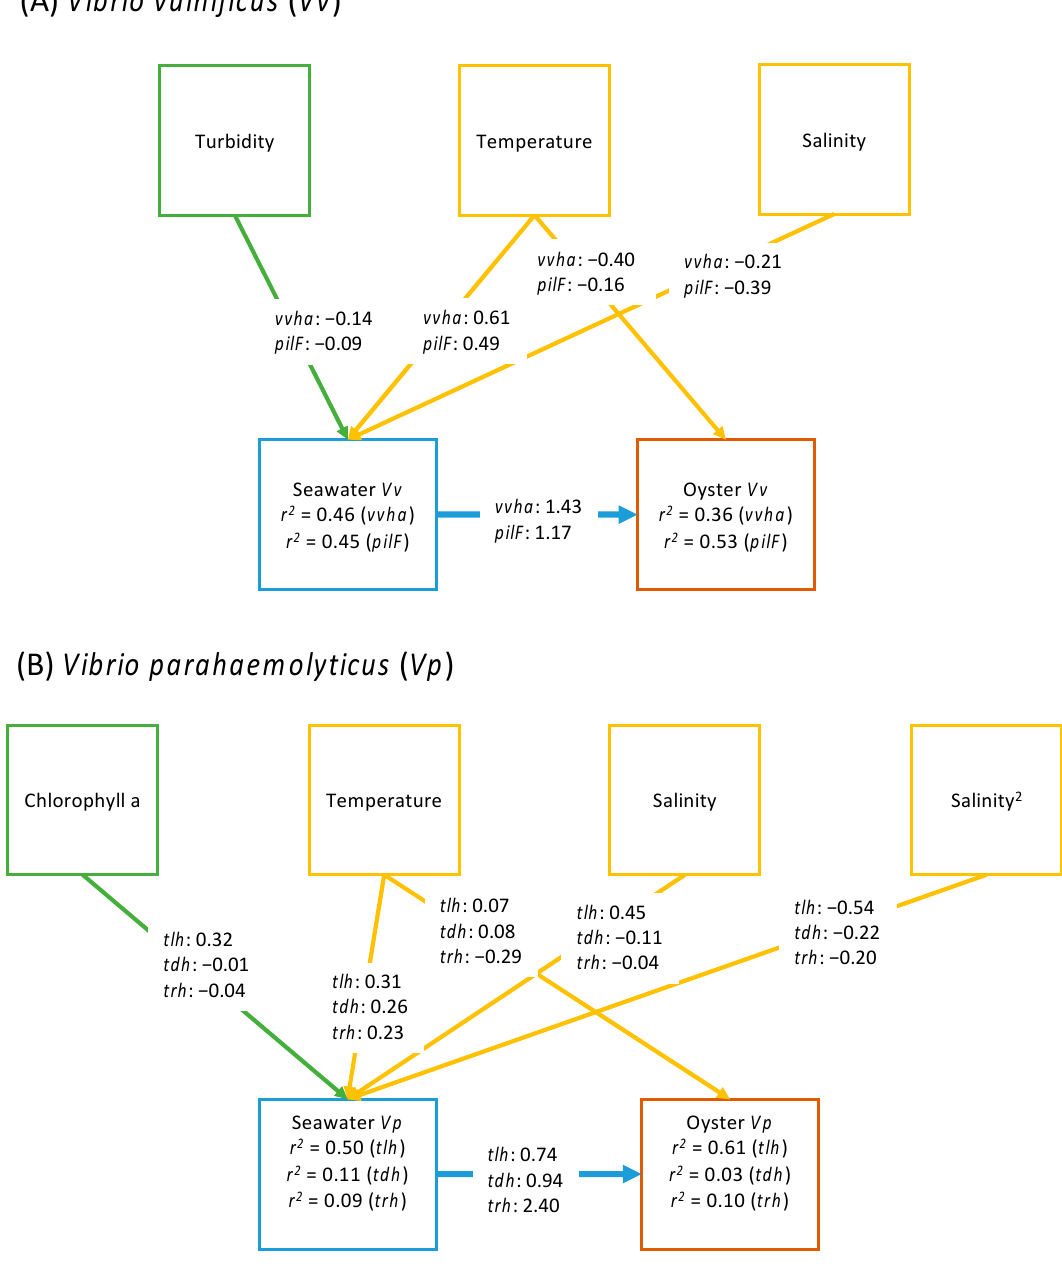
Figure 6. Results for the final selected models for each of the Vibrio vulnificus gene targets (( A ): vvha : χ 2 = 0.23, df = 1, p = 0.63; pilF : χ 2 = 3.80, df = 1, p = 0.05) and V. parahaemolyticus gene targets (( B ): tlh : χ 2 = 3.79, df = 2, p = 0.05; tdh : χ 2 = 3.25, df = 2, p = 0.20; trh : χ 2 = 3.63, df = 2, p = 0.16). Boxes represent observed variables and path coefficients are standardized values (standardized by the standard deviation of the variables) for each gene target. Proportional variance explained by the models for all dependent variables ( Vibrio spp. concentrations in seawater and oysters) are shown with each of these variables. Note the linear relationship between salinity and seawater V. vulnificus concentrations ( vvhA and pilF ) but convex relationship (specifying the SALINITY 2 term) between salinity and seawater V. parahaemolyticus ( tlh , tdh , and trh